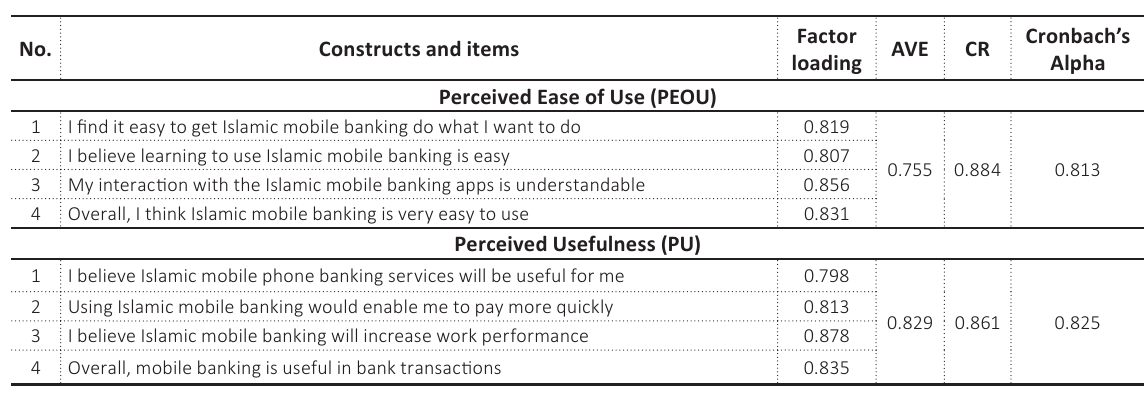
Table 1. Validity and